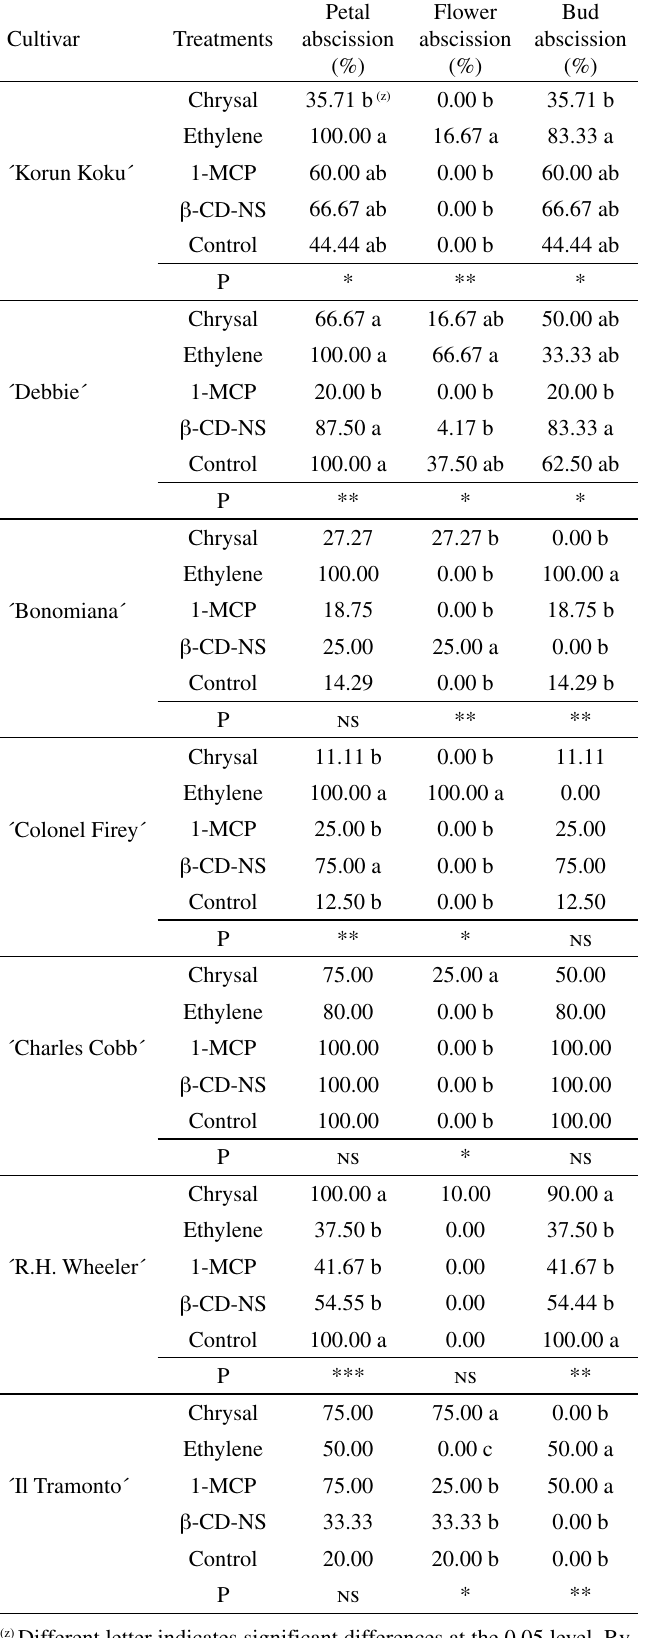
Table 2 - Petal, flower, and bud abscission of the studied Camellia ja- ponica cultivars subjected to five treatments and measured at the end of the experiment Cultivar